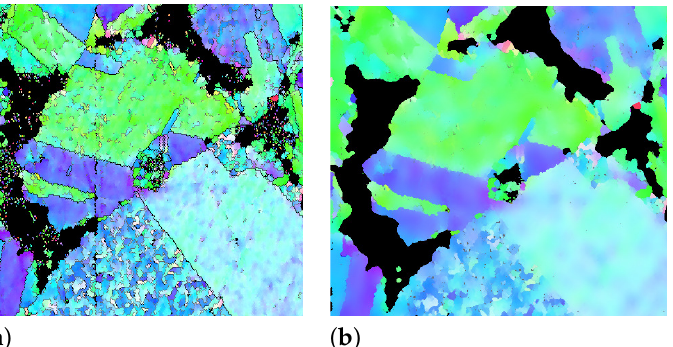
Figure 4. An example of data cleaning done for the original raw data in the preprocessing: ( a ) a cut- out of the original image in Figure 1a; ( b ) after the denoising.